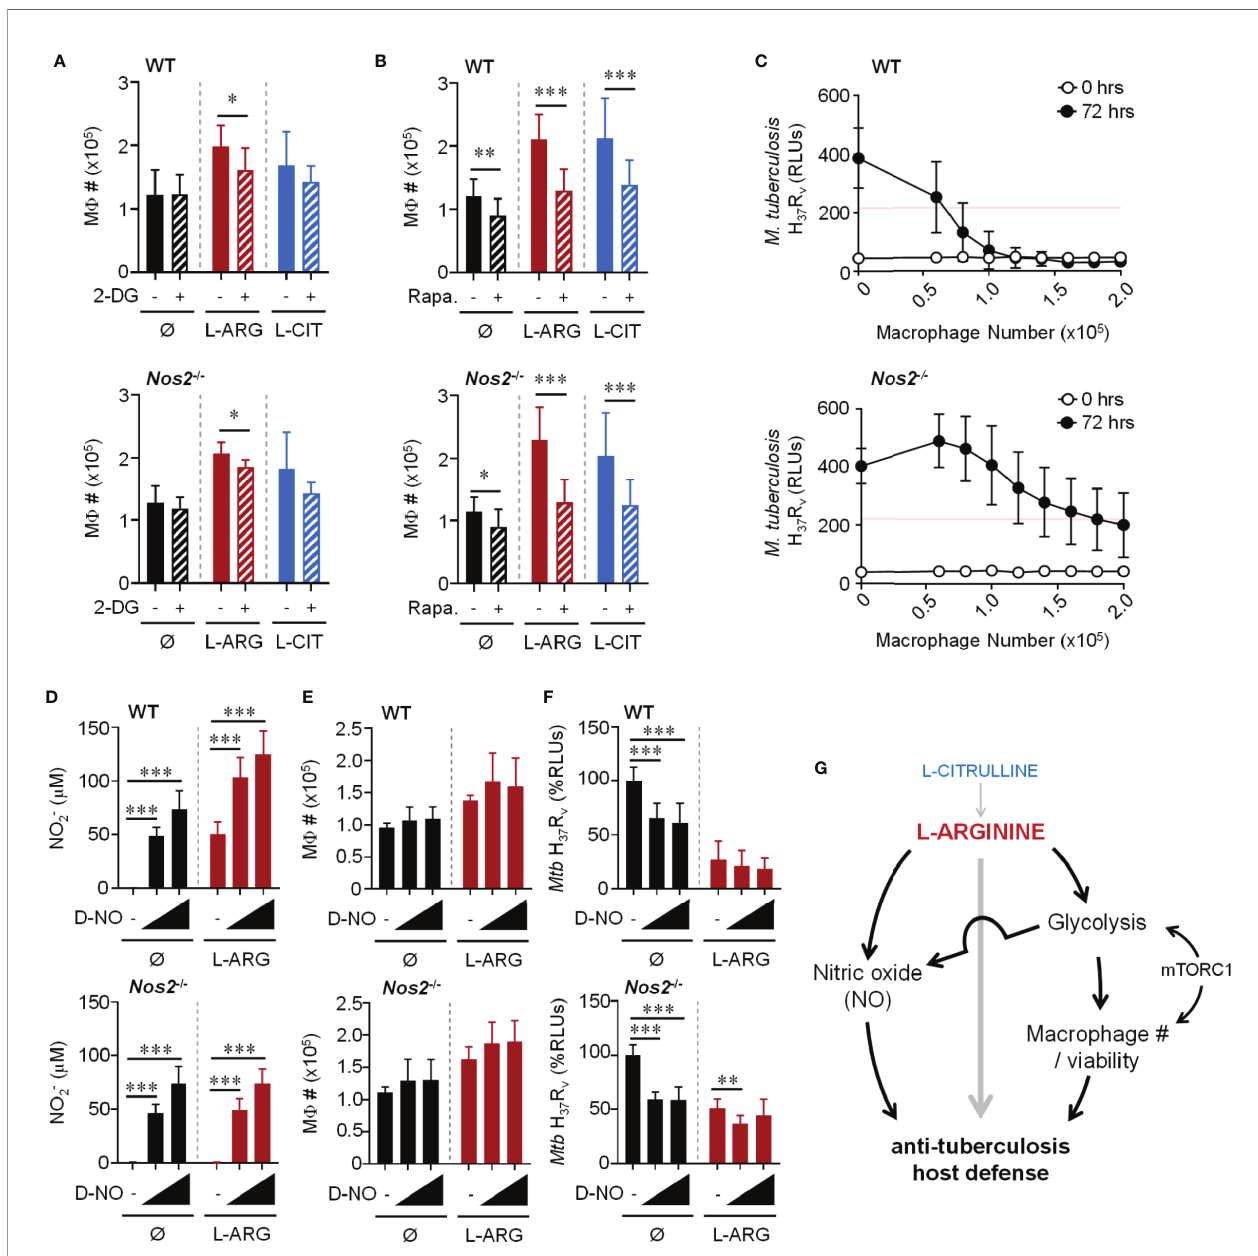
FIGURE 7 | Dual role for L-arginine in driving anti-mycobacterial function via increasing macrophage number and NO production. PM F s from C57Bl/6 (WT) or Nos2 -/- mice were infected with Mtb H 37 R v (MOI~1) plus IFN- g cultured in R-free C-DMEM containing 400 m M L-arginine, L-citrulline, or neither amino acid (Ø) with 2- DG (0.1 mM) (A) , rapamycin (20 nM) (B) , or appropriate controls. Macrophage numbers were determined by crystal violet assay at 72 hours post-infection (N ≥ 6, at least two experiments combined). (C) Titrated numbers of PM F s from WT or Nos2 -/- mice were cultured with Mtb H 37 R v (~2x10 5 CFUs) plus IFN- g in R-free C- DMEM containing 400 m M L-arginine. RLUs were determined immediately following infection and at 72 hours as in Figure 1 . (N ≥ 6, at least 2 experiments combined, red line represents 50% of the change in Mtb RLUs between 0 and 72 hours in the absence of macrophages). (D – F) PM F s from C57Bl/6 (WT) or Nos2 -/- mice were infected with Mtb H 37 R v (MOI~1) plus IFN- g cultured in R-free C-DMEM containing 400 m M L-arginine or no L-arginine (Ø). DETA-NONOate (D-NO) was added at low (80 m M) or high (120 m M) concentrations indicated by the triangle, or not added (-). At 72 hours post-infection NO − 2 production (D) , macrophage numbers (E) , and Mtb RLUs (F) and were determined as in Figure 1 and above (N ≥ 6, at least two experiments combined). *p < 0.05, **p < 0.01, ***p < 0.001, by Student ’ s t test (A, B) ; 1-way ANOVA with Fisher ’ s LSD post hoc analysis (D – F) . Error bars, SD. (G) Working model of pathways driven by L-arginine to assist in anti-mycobacterial macrophage